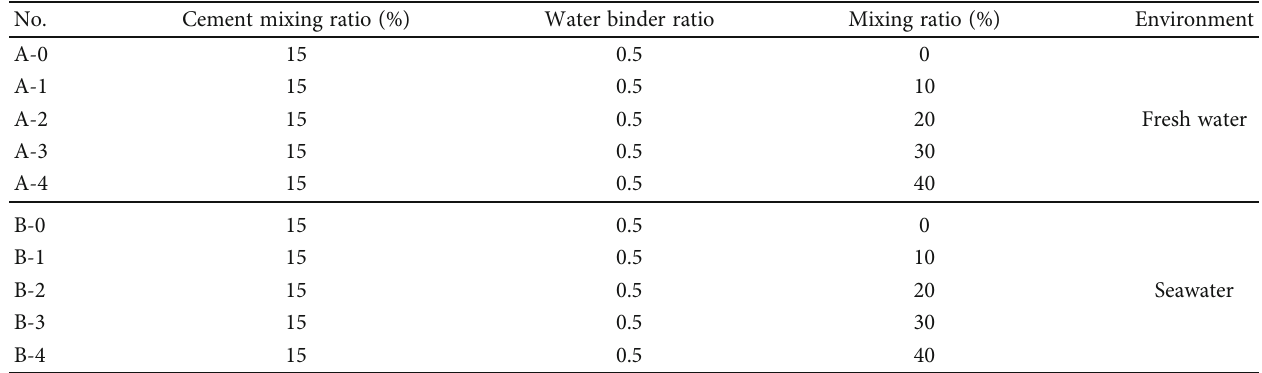
Table 4: Permeability test of soil-cement.